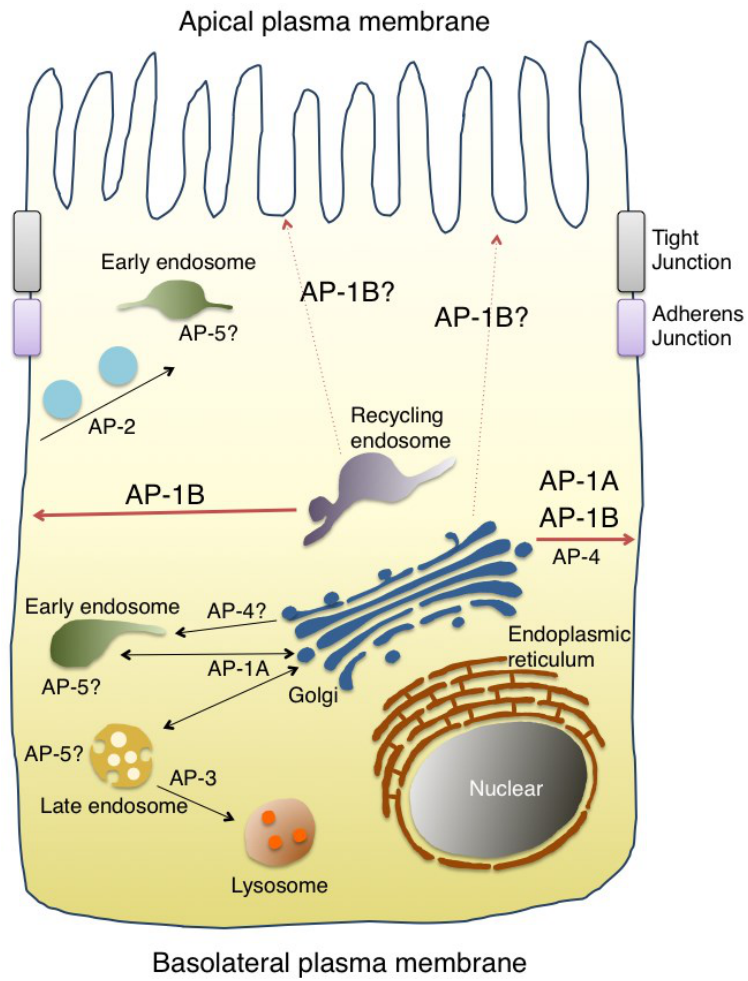
Figure 2. The post-Golgi network controlled by the AP complexes. The AP complexes are widely distributed throughout the post-Golgi network. AP-1A is localized at the TGN and endosomes and regulates the TGN-endosomal and the TGN-basolateral plasma membrane pathways. AP-2 is recruited to the plasma membrane for regulating endocytosis. AP-3A regulates the endosomal and the lysosomal trafficking pathways. AP-3B is involved in the biogenesis of specialized organelles, such as synaptic vesicles and dense core vesicles. AP-4 is involved in the TGN-endosomal and the TGN-basolateral plasma membrane pathways. A recently-identified AP-5 has been shown to localize at the endo-lysosomes. The epithelium- specific AP-1B and the ubiquitously-expressed AP-1A localize at the TGN and/or at the recycling endosome and control the polarized sorting to the basolateral plasma membrane. Defects in the localization of the apical proteins have been reported in a loss-of-function mutant of AP-1B, suggesting that AP-1B could be indirectly involved in the apical protein sorting. See the text for